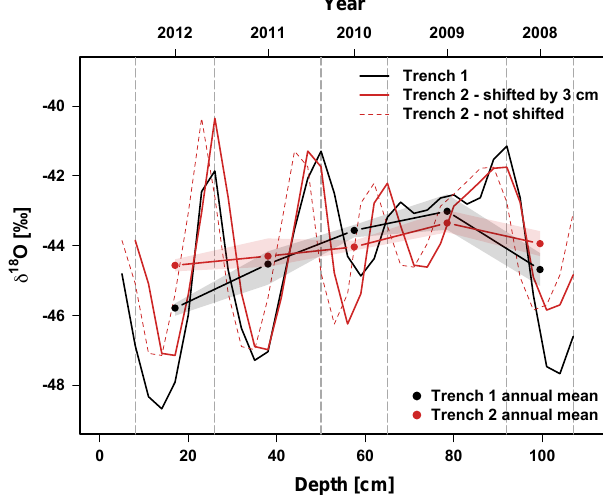
Figure 5. Comparison of the mean δ 18 O profiles (lines: seasonal, points: annual mean) from T1 (black) and T2 (red). To maximise the seasonal correlation ( r T1,T2 = 0 . 81), trench T2 was shifted by + 3cm. For the first three depth bins, the number of existing obser- vations varies on absolute coordinates between the trench profiles. To obtain non-biased seasonal mean profiles only the depth range covered by all profiles is used. Shading represents the range of the approximate annual-mean profiles due to different binning defini- tions. Note that their first and last value are biased since the trench data are incomplete here. Vertical dashed grey lines mark the six local maxima of the average of both seasonal mean